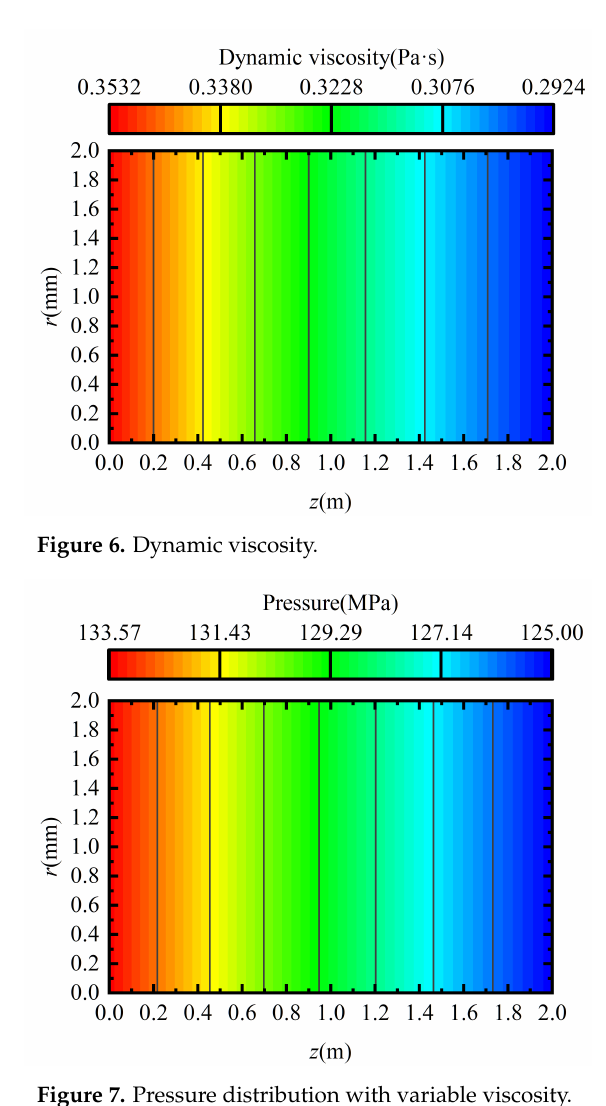
Figure 7. Pressure distribution with variable